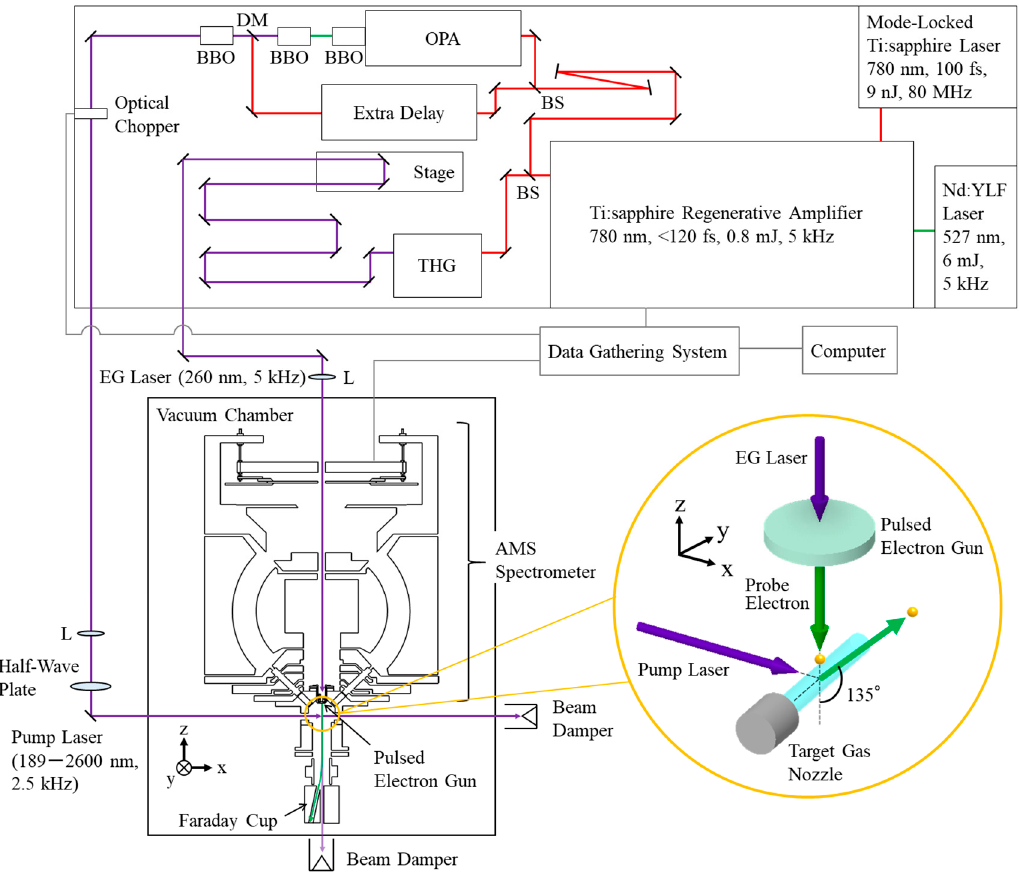
Figure 1. Schematic of a time-resolved atomic momentum spectroscopy (TR-AMS), consisting of a femtosecond laser system, a vacuum chamber, a target gas nozzle, a pulsed electron gun, a Faraday cup, a multichannel AMS spectrometer, and a data gathering system. Abbreviations are as follows: BS, beam splitter; OPA, optical parametric amplifier; THG, third harmonic generator; BBO, β -barium borate; DM, dichroic mirror; L, lens; EG, electron-generation.